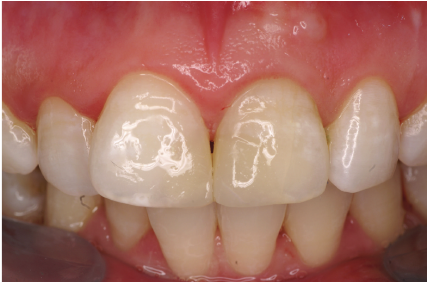
Figure 13: Aesthetic result achieved after peeling, teeth whitening, and composite